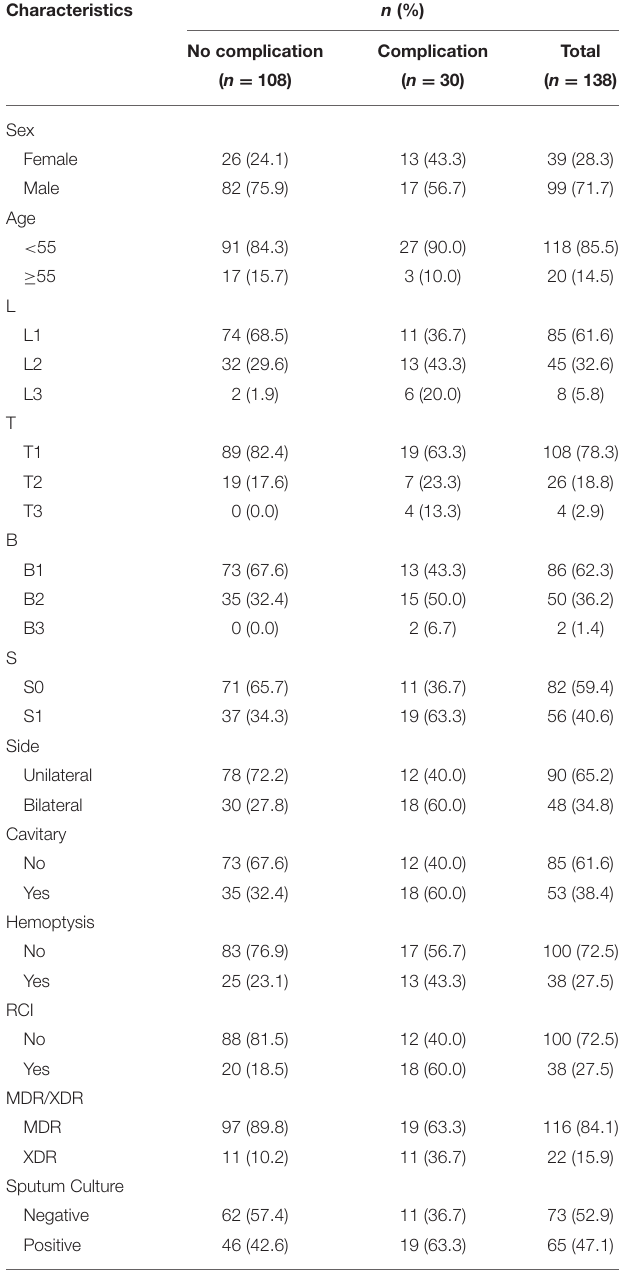
TABLE 2 | Demographic and clinical characteristics of complication and non-complication groups.